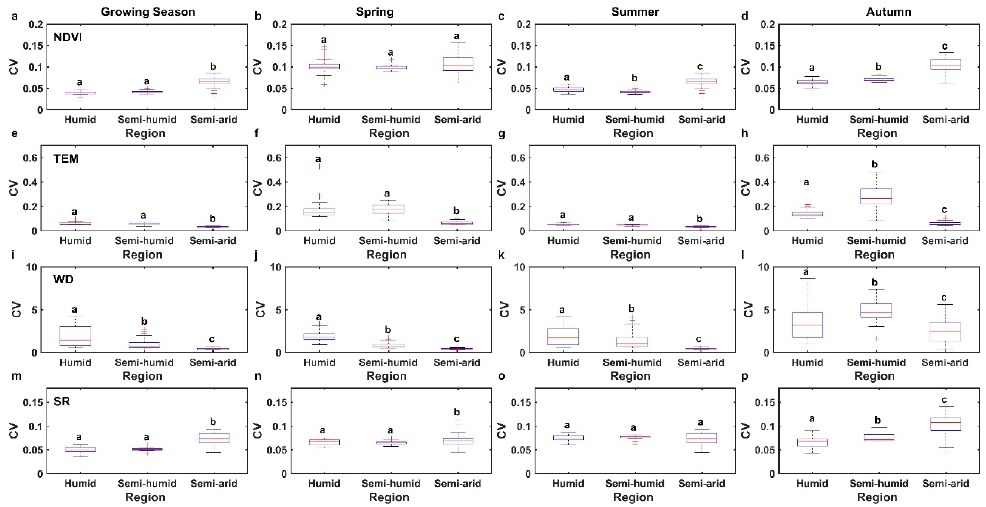
Figure 8. The coefficient of variation (CV) of NDVI ( a – d ), TEM ( e – h ), WD ( i – l ), and SR ( m – p ) in different seasons along the drought gradient. Different letters in each subplot indicate significant differences in one-way ANOVA analyses among the three categories of MAI (humid, semi-humid and semi-arid) at p < 0.05.